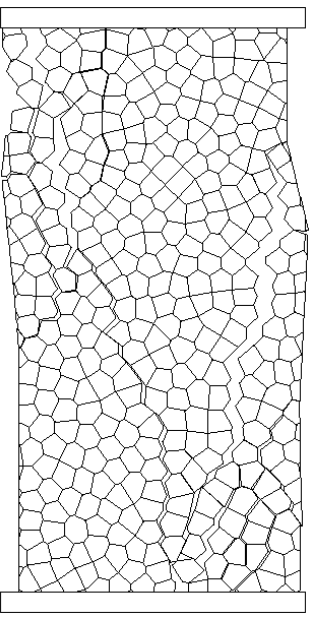
Figure 9. Applied stress vs. vertical strain.